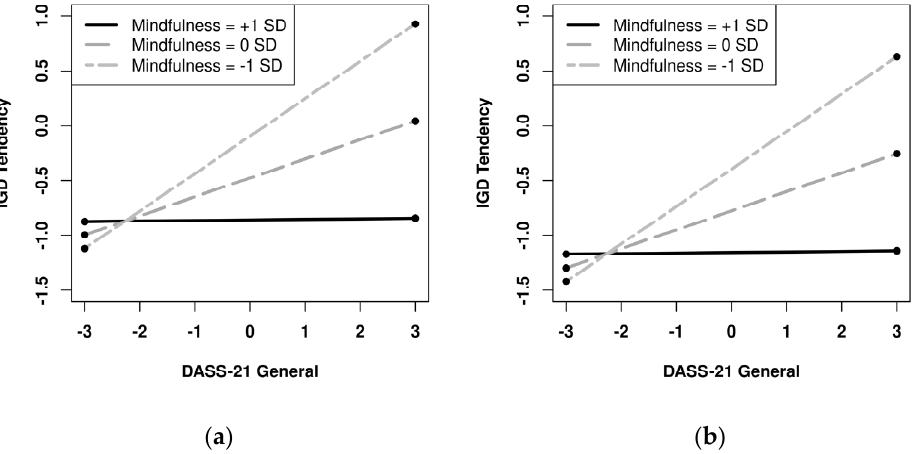
Figure 1. Interaction between DASS-21 General and Mindfulness on IGD Tendency for females in Japan ( a ) and China ( b ).